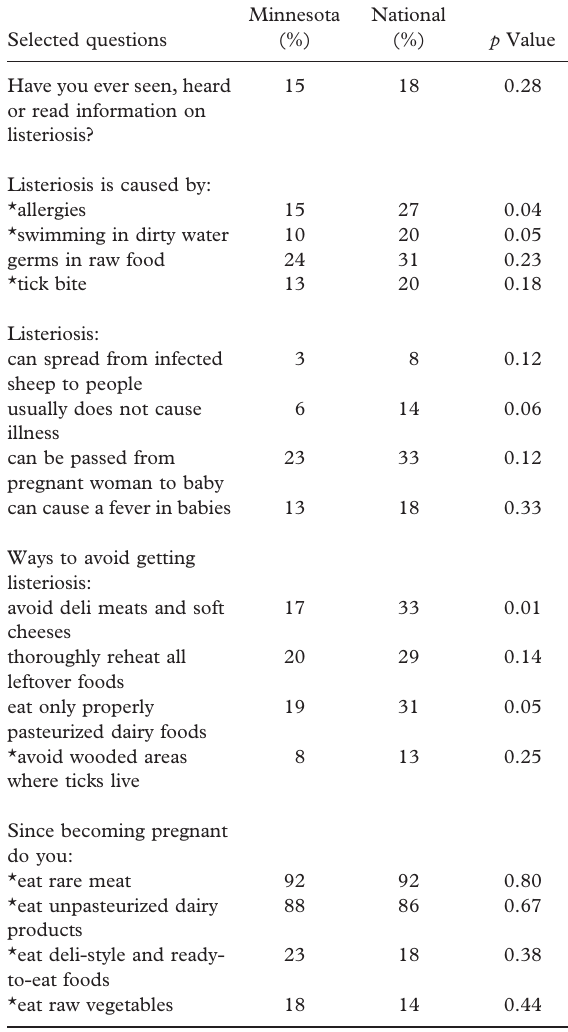
Table III. Correct responses to selected listeriosis questions.